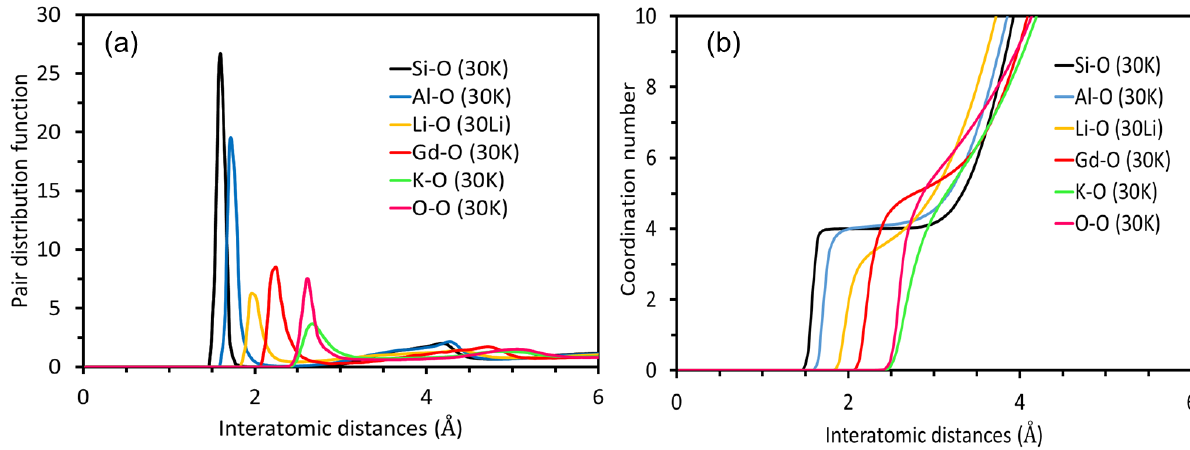
Figure 3. The radial distribution functions ( a ) and the coordination numbers ( b ) of the different atom pairs in the peralkaline alkali aluminosilicate glasses 30K and 30Li.